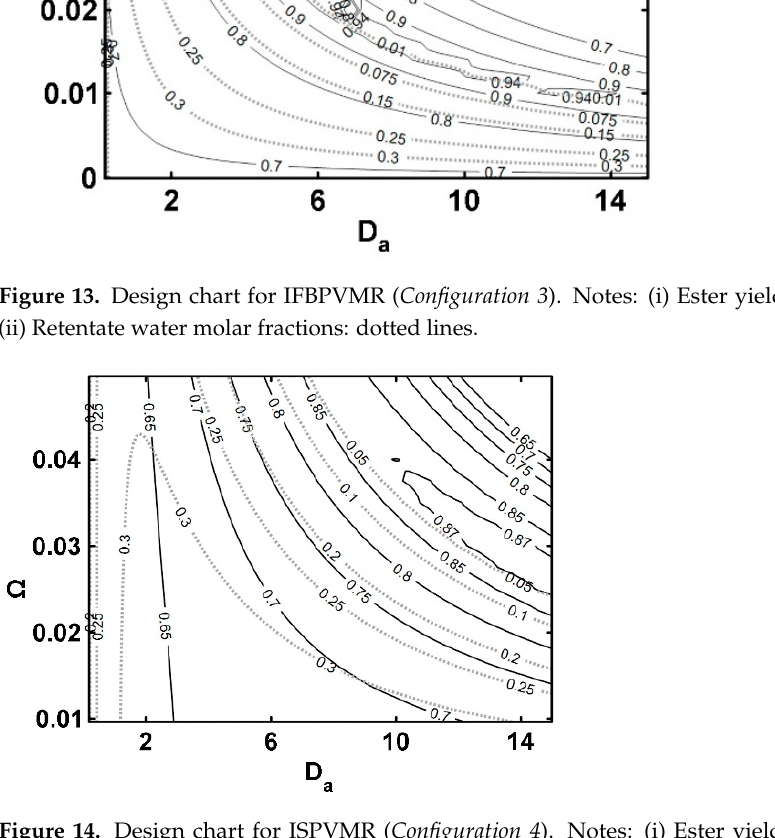
Figure 14. Design chart for ISPVMR ( Configuration 4 ). Notes: (i) Ester yields: continuous lines, (ii) Retentate water molar fractions: dotted lines.